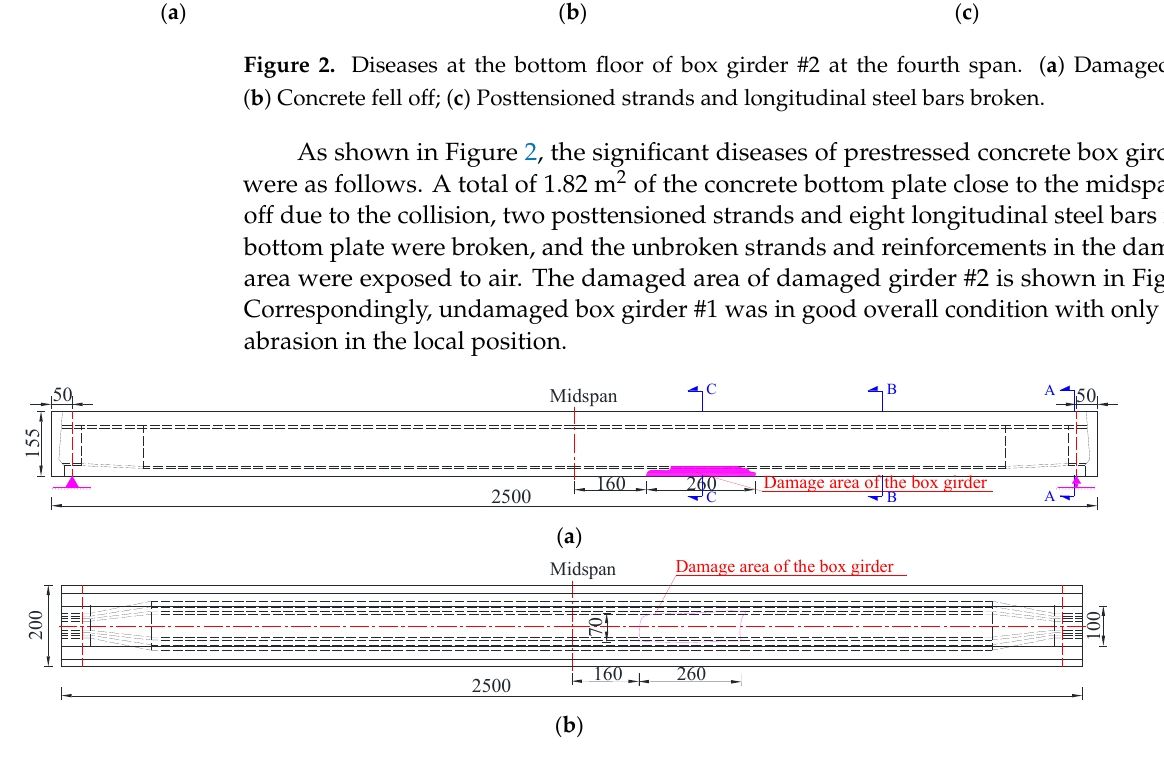
Figure 3. Damaged area of damaged girder #2 at the fourth span (Unit: cm). ( a ) Front view; ( b ) Bottom view.